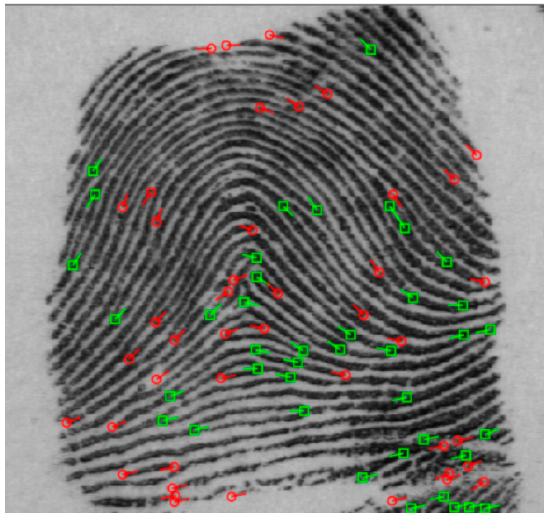
Figure 17. Fingerprint minutiae extraction. Image f0275_02.png from the NIST fingerprint database [41].